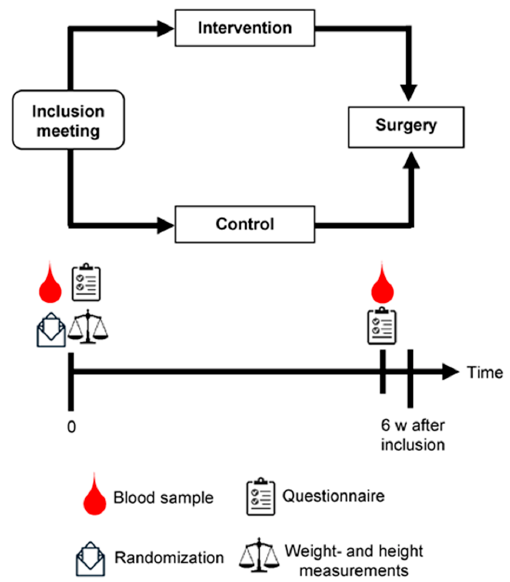
Figure 1. Design of the PRODICA (the impact of DIet and individual genetic factors on tumor proliferation rate in men with PROstate CAncer) study. During the inclusion meeting, participants were randomized to an intervention or a control group, filled out a questionnaire, and blood samples were collected. A similar questionnaire was filled out and blood samples were collected again within seven days before the time of surgery. The intervention was intended to last approximately 6 weeks.